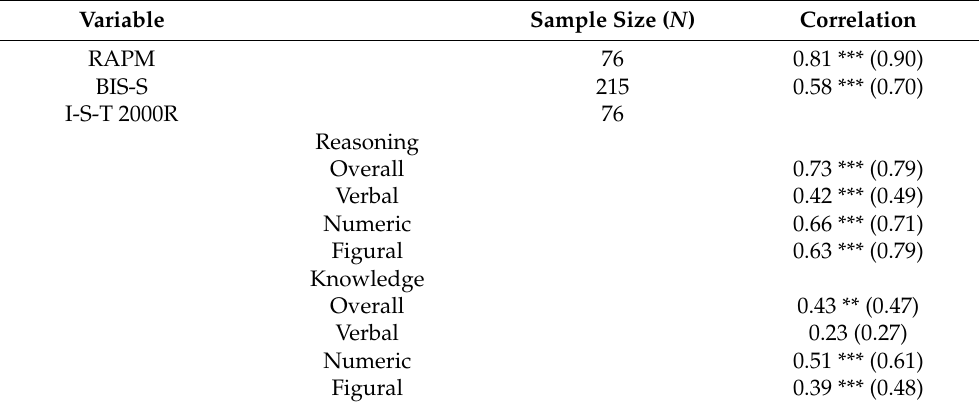
Table 5. Correlations between the HeiQ and intelligence measures.